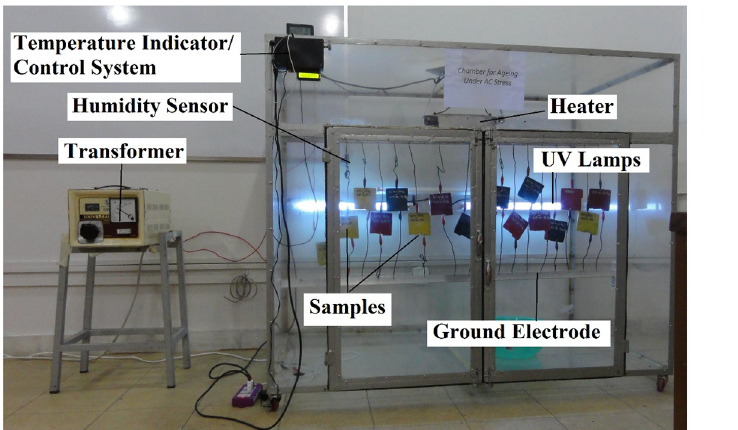
Fig 3. Real photograph of the aging chamber.